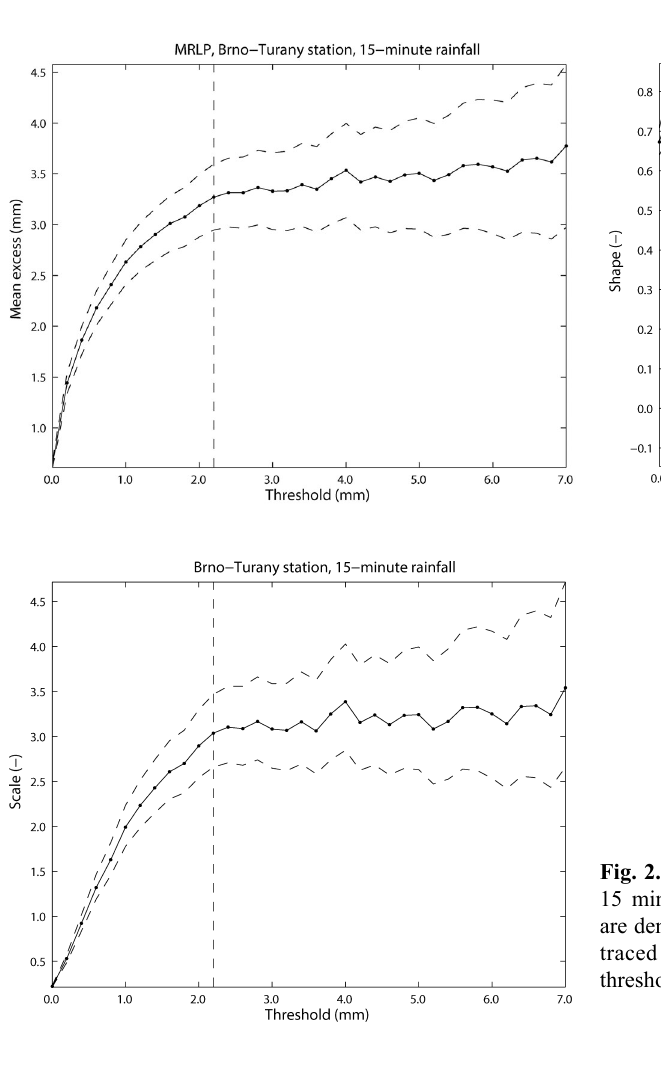
Table 2. Threshold values u (mm) identified for various aggregation levels